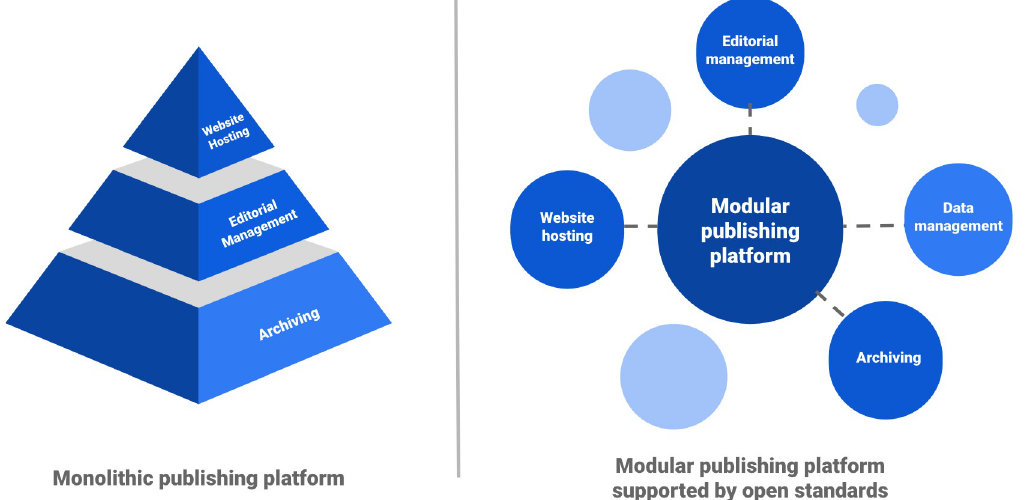
Fig 1. Contrasting monolithic and modular publishing platforms. While monolithic publishing platforms are self-contained, modular publishing platforms rely on open standards across composable infrastructure. In doing so, they create space for additional functionality such as data management that better supports scientific